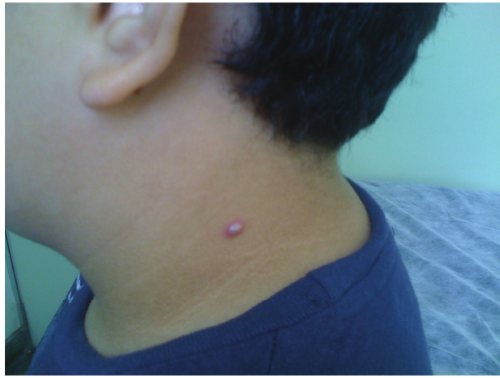
Figure 1: Well defined papule of firm consistency on neck.